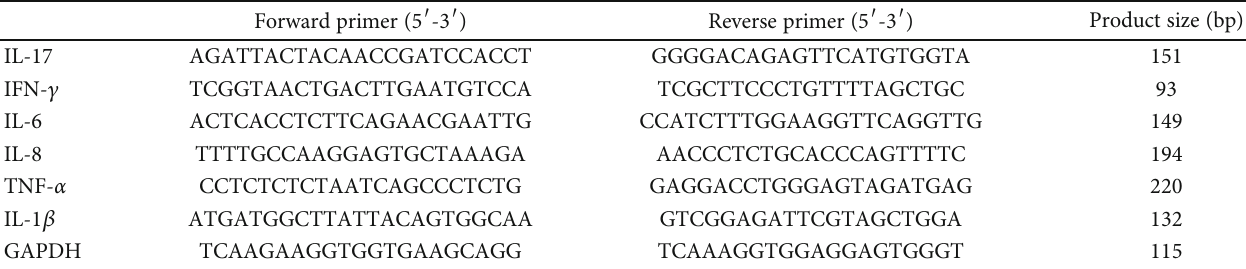
Table 2: Sequence of primers used for